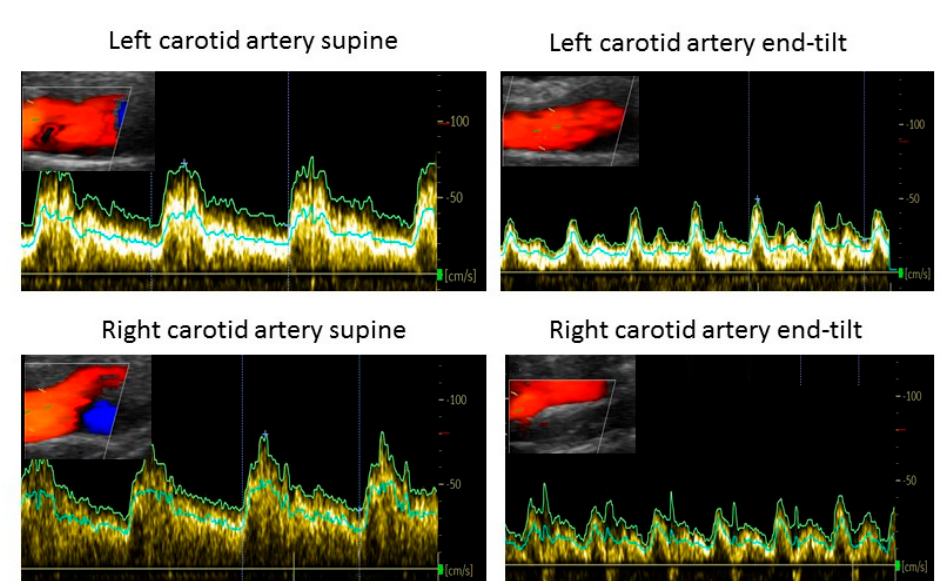
Figure 2. Example of cerebral blood flow measurements of the left carotid artery supine ( upper left ) and end-tilt ( upper right ) and of the right carotid artery supine ( lower left ) and end-tilt ( lower right ) of the example case of: “PPS”.